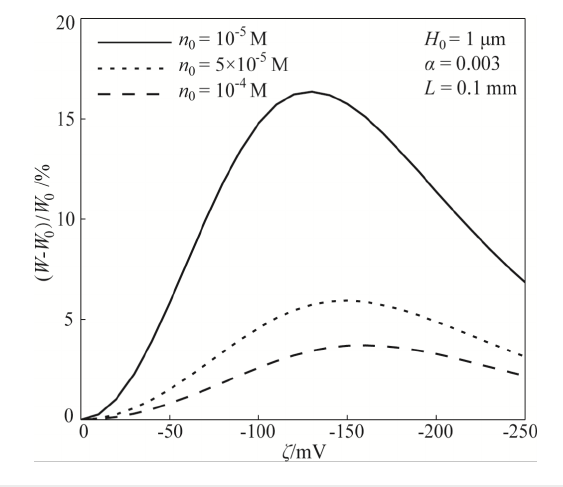
Figure 6: The effect of zeta potential on the hydrodynamic load capacity of the lubricant and the dependence of the hydrodynamic load capacity on the ion concentration based on the model of nonlinear PBE and varying electrical